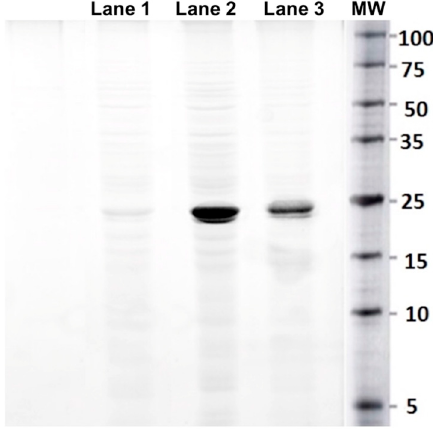
Figure 5. SDS-PAGE gel prepared from cytosolic protein Stenotrophomonas maltophilia (Strain NA2): Lane 1. Native strain exposed to 0 mg/L of chromium VI. Lane 2. Native strain exposed to 500 mg/L of chromium VI. Lane 3. Native strain exposed to 100 mg/L of chromium VI. Lane 4. Protein molecular weight marker.